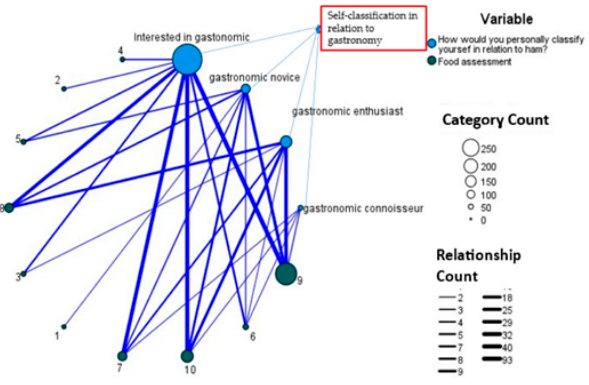
Figure 3. Relationship map. Source: own elaboration. For a more in-depth analysis of the relationship between the different variables, bivari- motivation to engage in gastronomic tourism ( χ 2 = 325.71, p ≤ 0.001): the older the tourist,